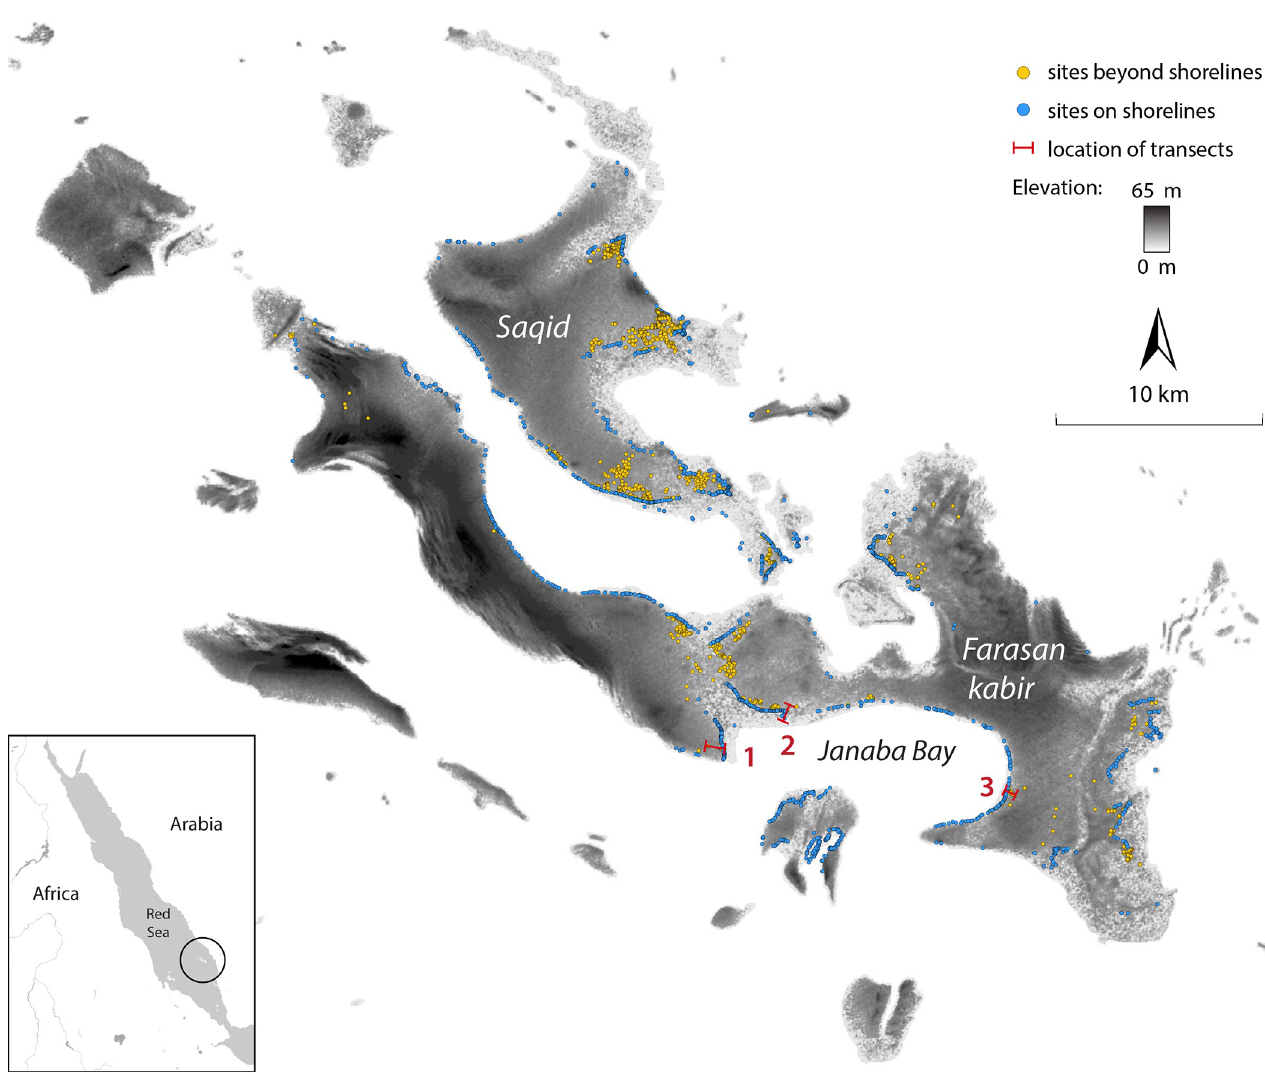
Fig 1. Elevation map of the Farasan Islands, showing the spatial distribution of shell midden sites. Blue dots are shoreline middens, yellow dots are post- shore sites. The three transects with the sites selected for detailed radiocarbon dating are all in Janaba Bay and are shown in red. We refer to these as Janaba West (1), Janaba West-Central (2), and Janaba East (3).